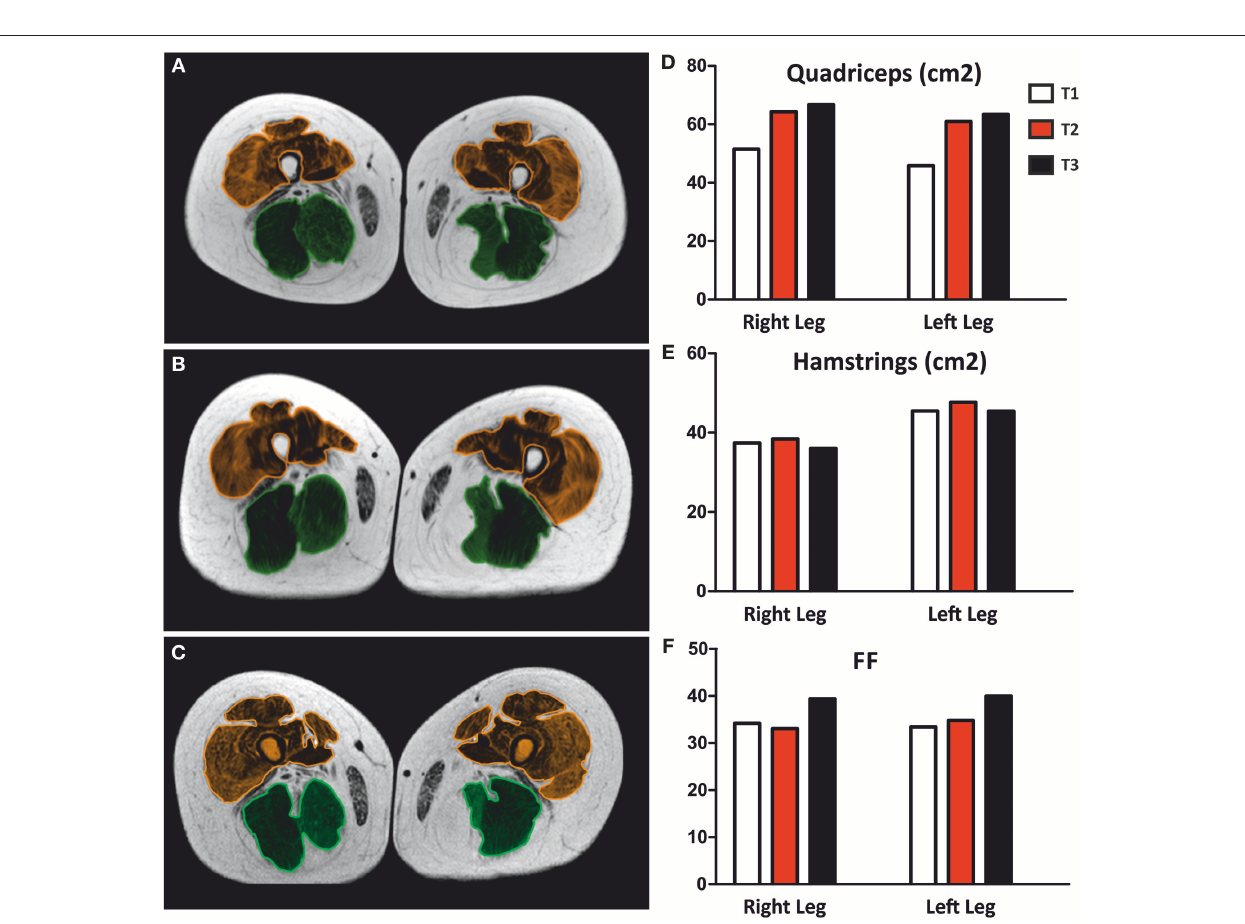
FIGURE 3 | Magnetic Resonance Imaging (MTI) of thigh muscles . MRI was performed after 5 ( A ; T1), 14 ( B ; T2), and 26 months ( C ; T3) of home-based FES. The cross-sectional area of quadriceps (brown) and hamstrings (green) muscles was estimated and plotted in (D,E) , respectively. Histogram in (F) show the variation of fat fraction (FF) during FES